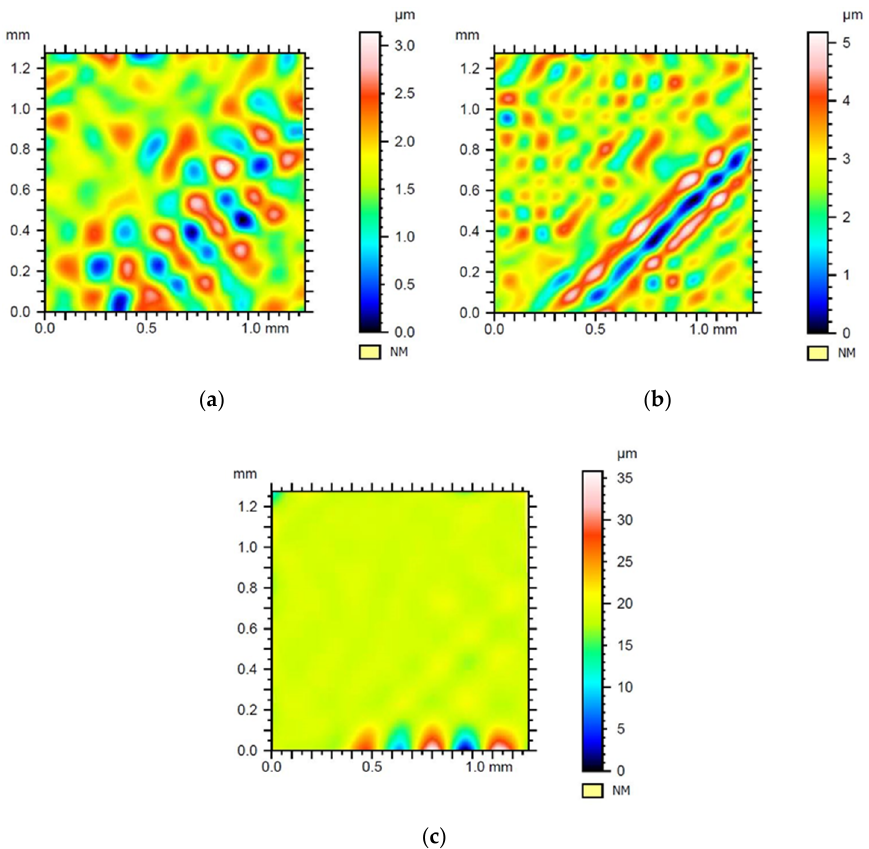
Figure 23. The surface was created as a result of subtracting the structure obtained with the wavelet from the structure after applying Gaussian filtration ( a ) Daubechies wavelet, ( b ) Morlet wavelet, ( c ) Mexican hat wavelet. The root mean square error: ( a ) 0.48 μm, ( b ) 0.72 μm, ( c ) 1.63 μm.